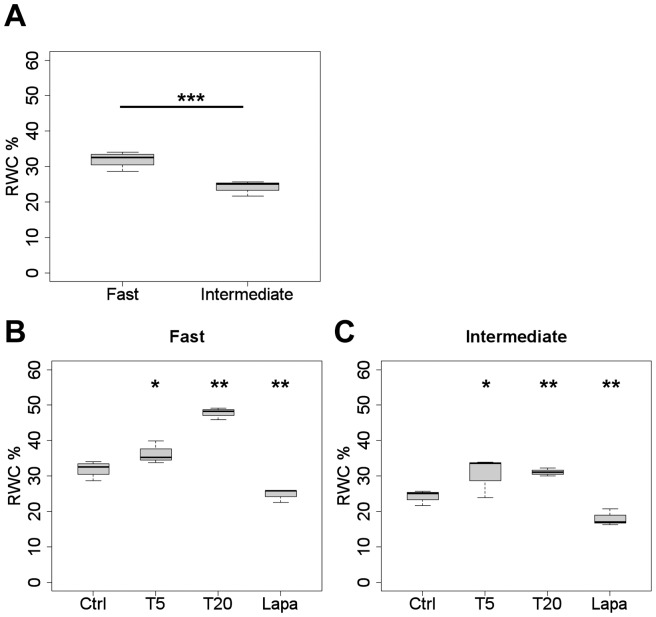
Distinct CLP migratory groups persist under low serum conditions.The graphs show the RWC in scratch wound assays at 24 h in 0.3% FCS/DMEM (*p<0.05, **p<0.01, ***p<0.001). (A) Despite a general decrease of the RWC, “fast” and “intermediate” CLP groups could still be distinguished under low-serum conditions. (B, C) Effect of exogenous TGF-α diluted at 5 ng/ml (T5) and 20 ng/ml (T20), as well as of 5 µM Lapatinib (Lapa) on both CLP subgroups under low serum conditions in comparison to controls (Ctrl).